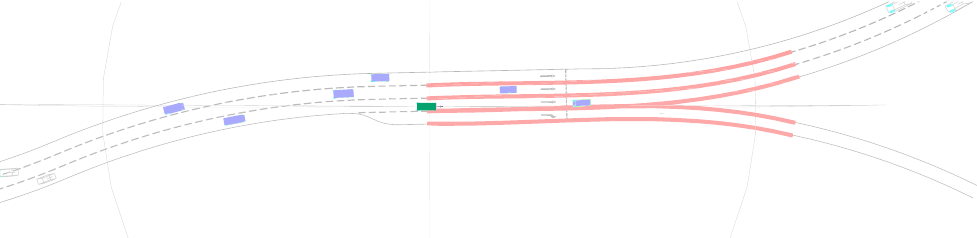
Figure 2. Simulation environment. Training and evaluations were performed in the simulation of a randomly-generated multi-lane highway. Ground truth vehicles and road (light gray on the figure) are parsed by the sensor models to produce vehicle state estimations (in blue) and lane markers geometry model (in red). The ego vehicle (green) is controlled by the direct control